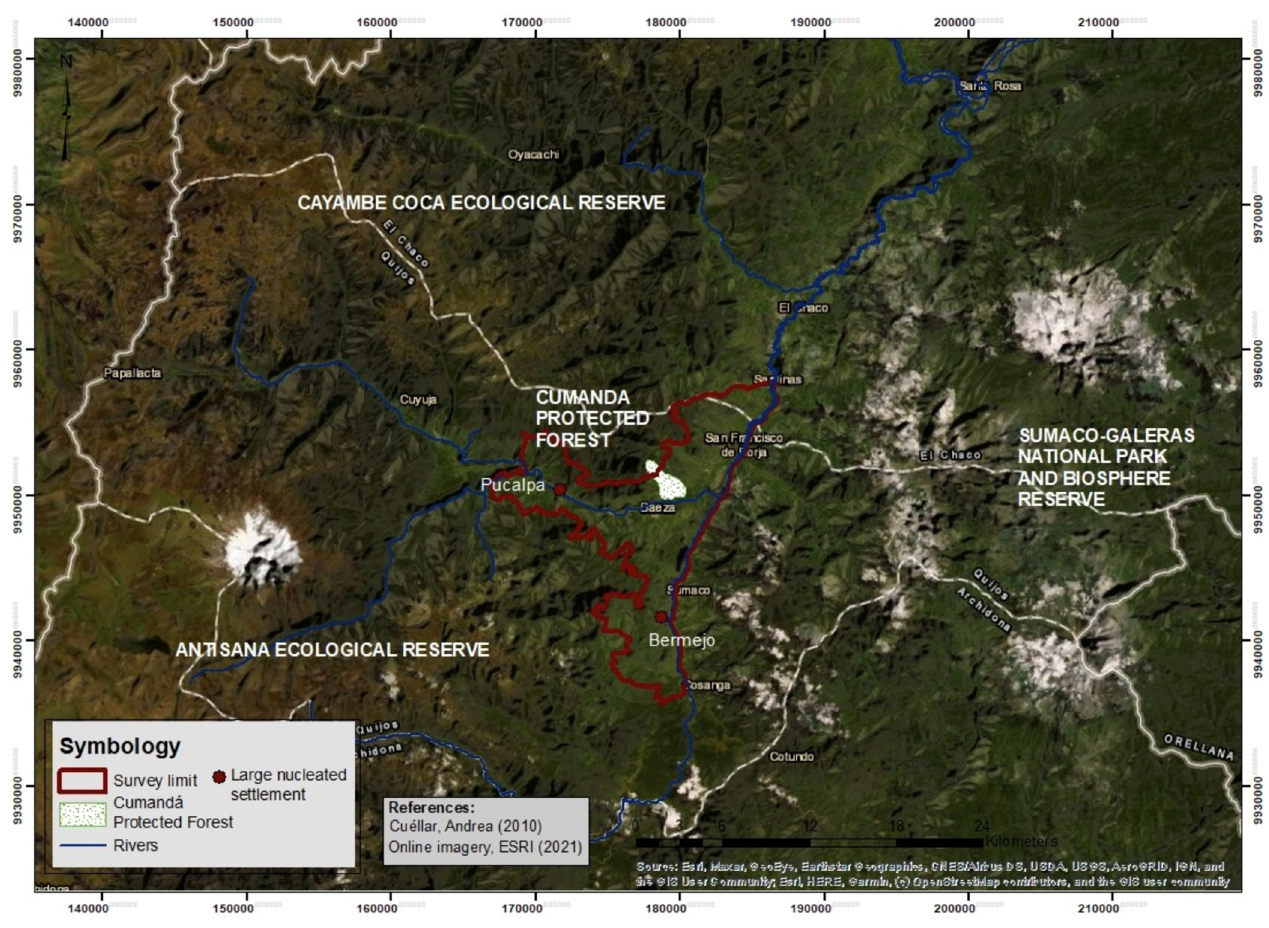
Figure 1. Map of the Quijos River basin, including the Antisana volcano, the protected areas of the national system, and the private reserve that helps contain the deforestation front of the Andean flank at the gateway to the Amazon River. Source: database Cuéllar (2010) and imagery ESRI (2021). Map elaboration by Ing. Paola Nicole Parra Curimilma.